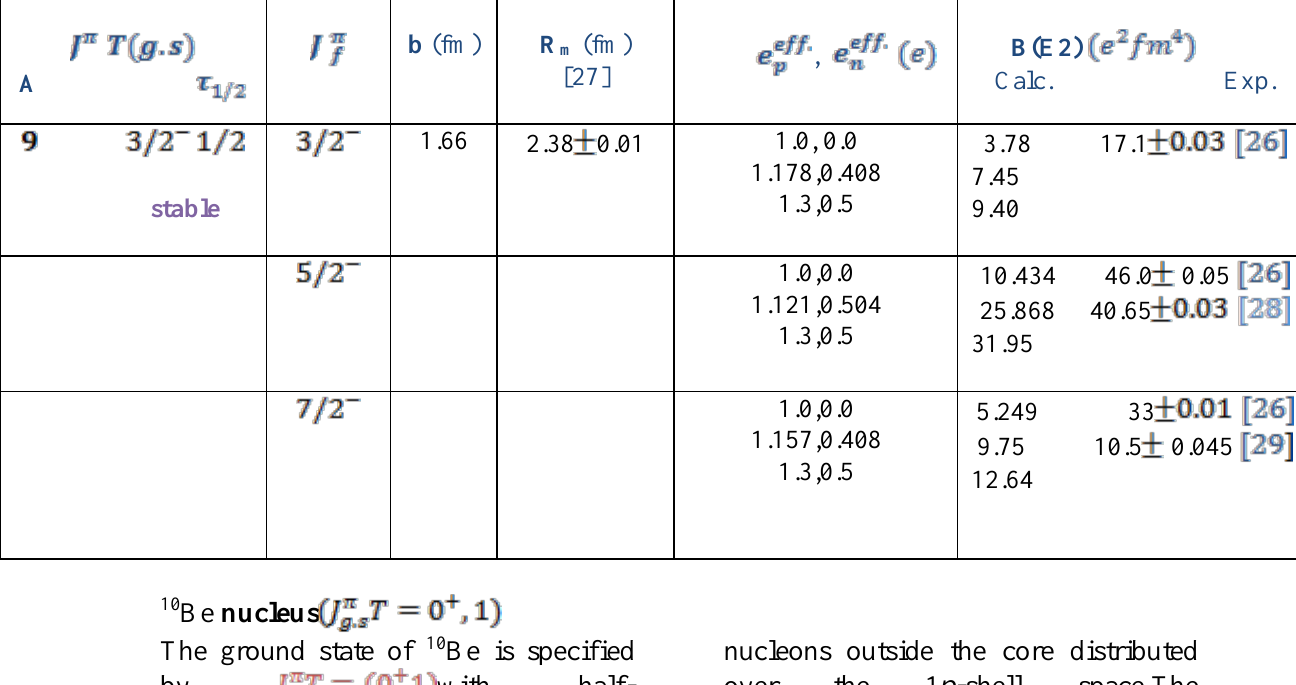
Table 1:The calculated effective charges and B(E2) values of 9 Be compared with the experimental